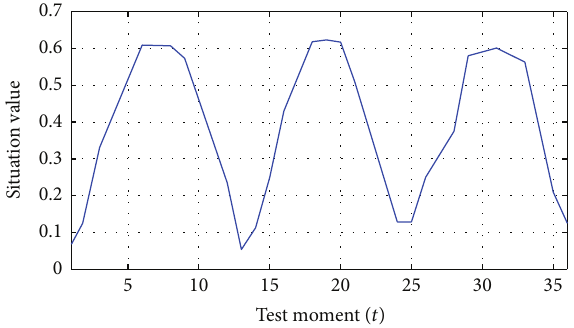
Figure 4: Historical records of network attack situation.